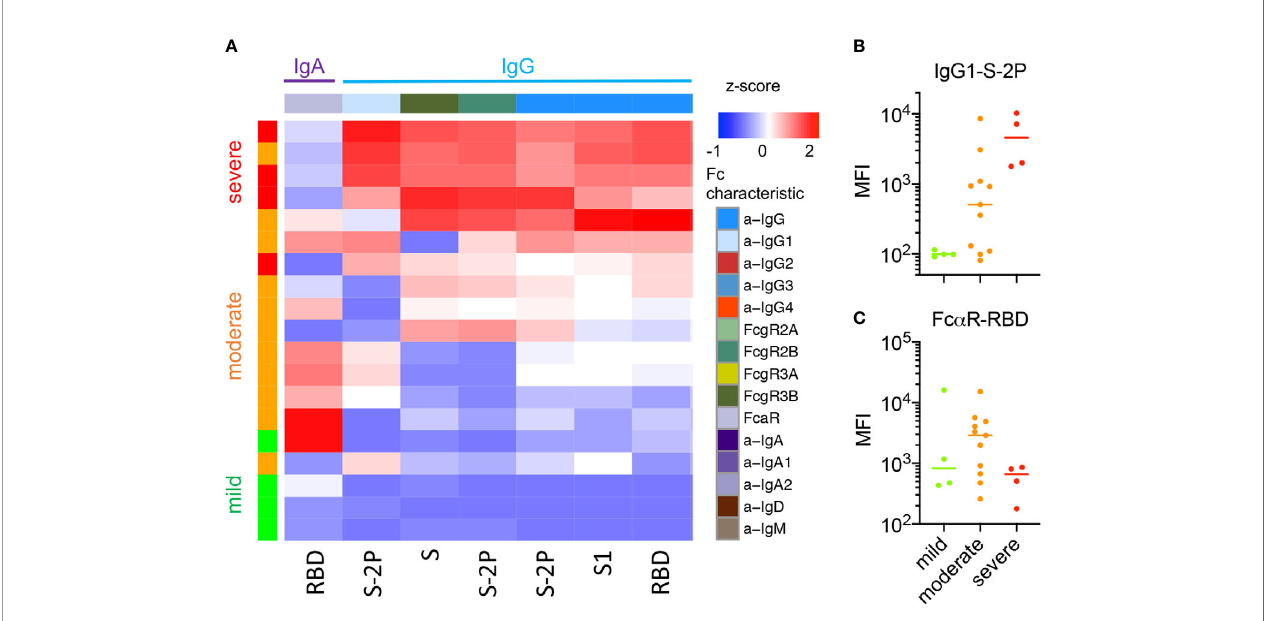
FIGURE 5 | Nasal Ab features associated with disease severity. (A) Heatmap of nasal CoV-2-speci fi c Ab features that exhibited statistically signi fi cant differences in responses between subjects with severe and non-severe (mild or moderate) disease (unpaired two-sided t-test with Welch ’ s correction, p < 0.05). (B, C) Representative boxplots of nasal features by disease severity across donors who experienced mild, moderate, and severe disease. (B) IgG1 speci fi c to S-2P as a representative Ab feature elevated among subjects with severe disease. (C) Fc a R binding Abs speci fi c to RBD are highest among individuals who recovered from moderate disease as opposed to either mild or severe